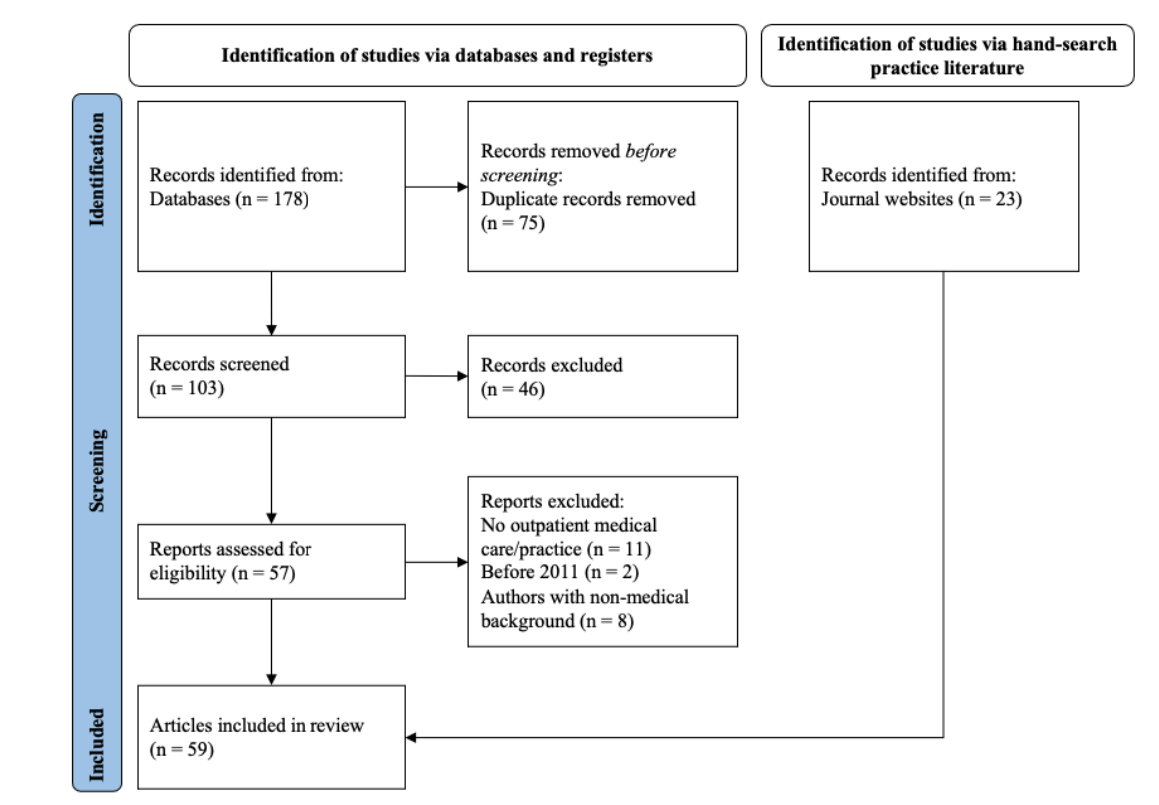
Figure 1. Flow diagram of the scoping review.